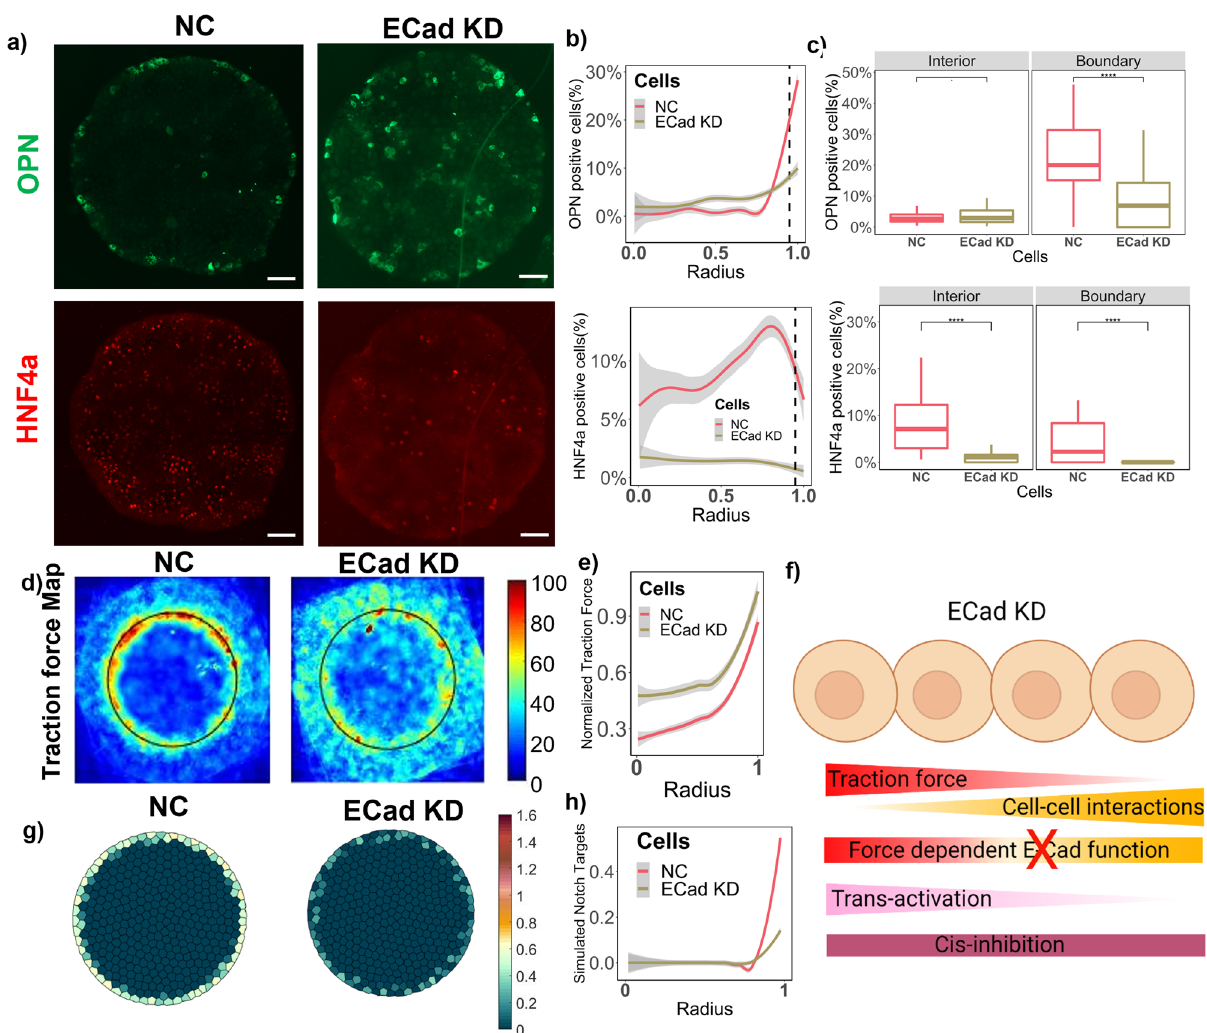
Fig. 4 Effect of intrinsic E-Cadherin siRNA knockdown on patterned differentiation. a Representative fl uorescent Images of Negative Control (NC), and ECad KD BMELs on Col 1 microarrays on 25 kPa polyacrylamide hydrogels. Red: HNF4a, Green: OPN. Scale Bar: 100 μ m. b Quanti fi cation of average percent HNF4a + and OPN + cells/island as a function of the radius. 0 is center, 1 is the edge, vertical dashed line at radius = 0.95. c Quanti fi cation of average percent HNF4a + and OPN + cells/island in the interior (radius = 0 – 0.95) and at the boundary (radius = 0.95 – 1.00). ‘ . ’ : ns; **** p -value <